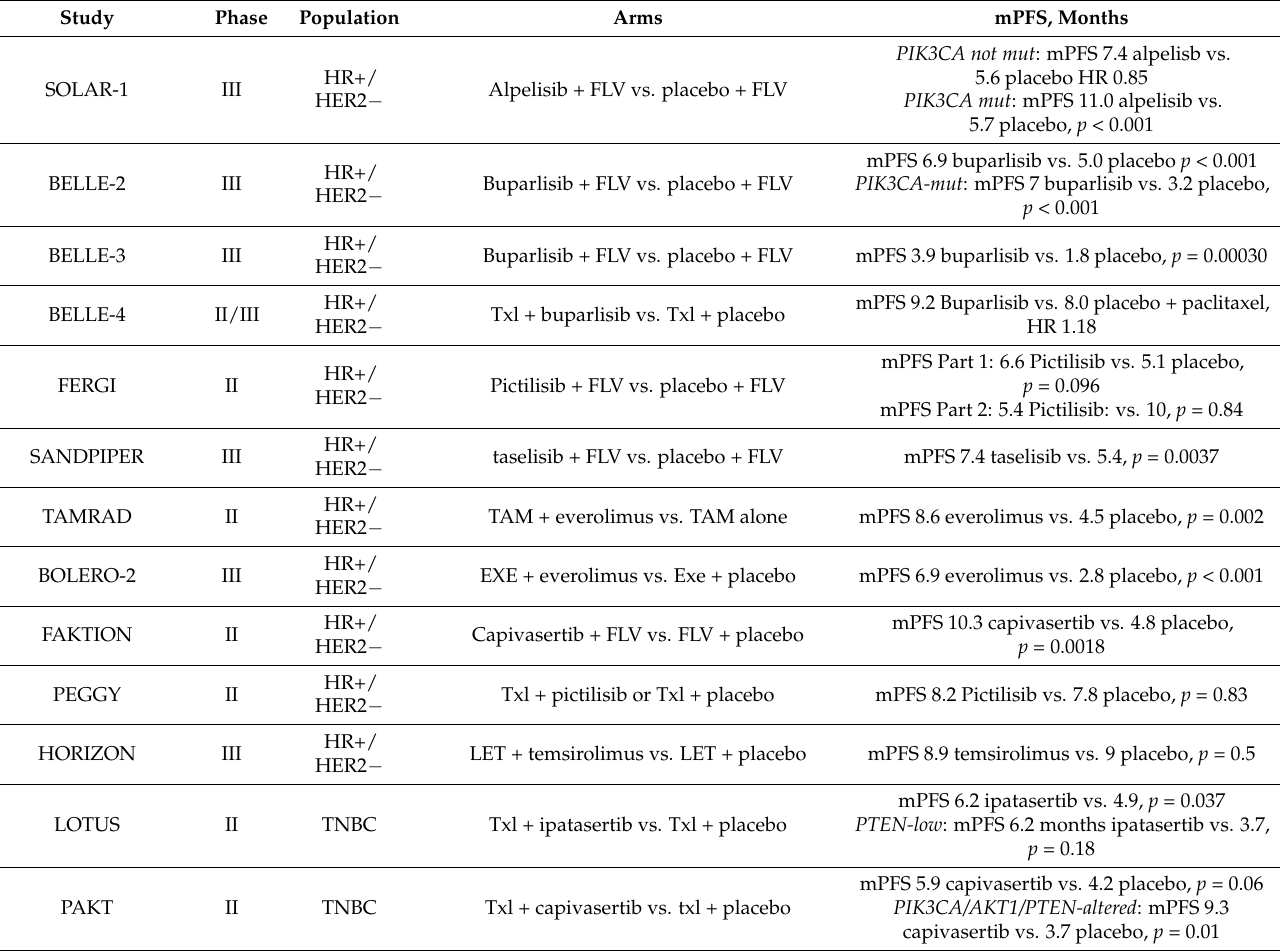
Table 4. Phase II/III trials of PI3K/AKT/mTOR inhibitors in advanced breast